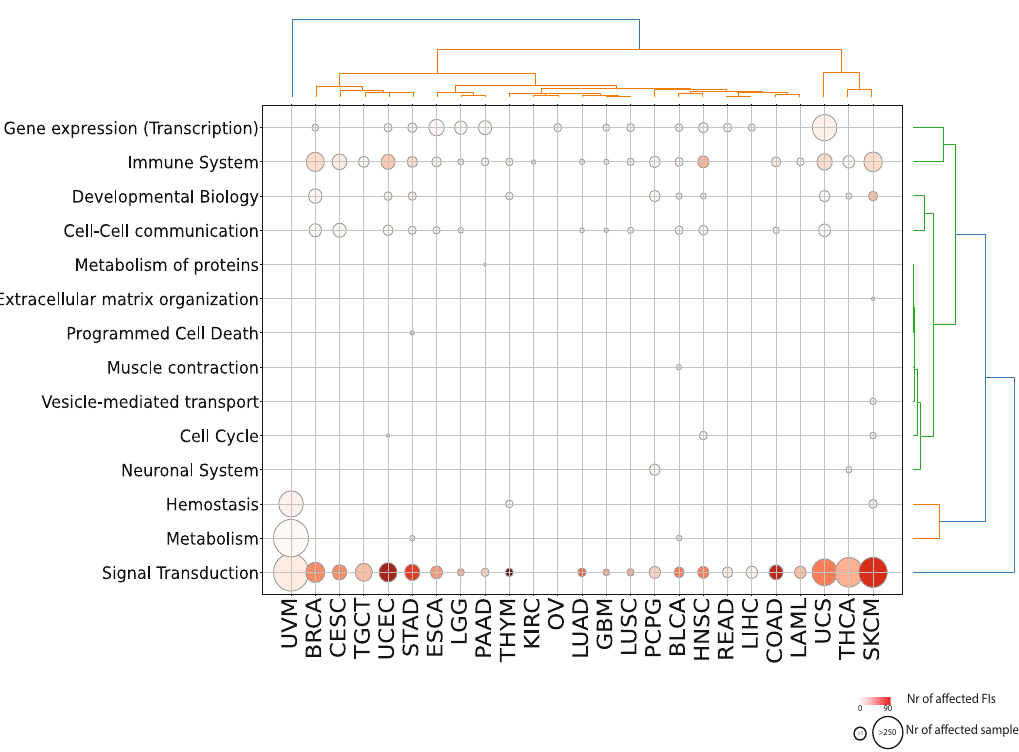
Figure 3. Significantly affected reactions in individual TCGA cancer types mapped to top level Reactome pathways. Diameters are proportional to the numbers of unique samples having mutations in top level pathways and color shades are proportional to the numbers of FI